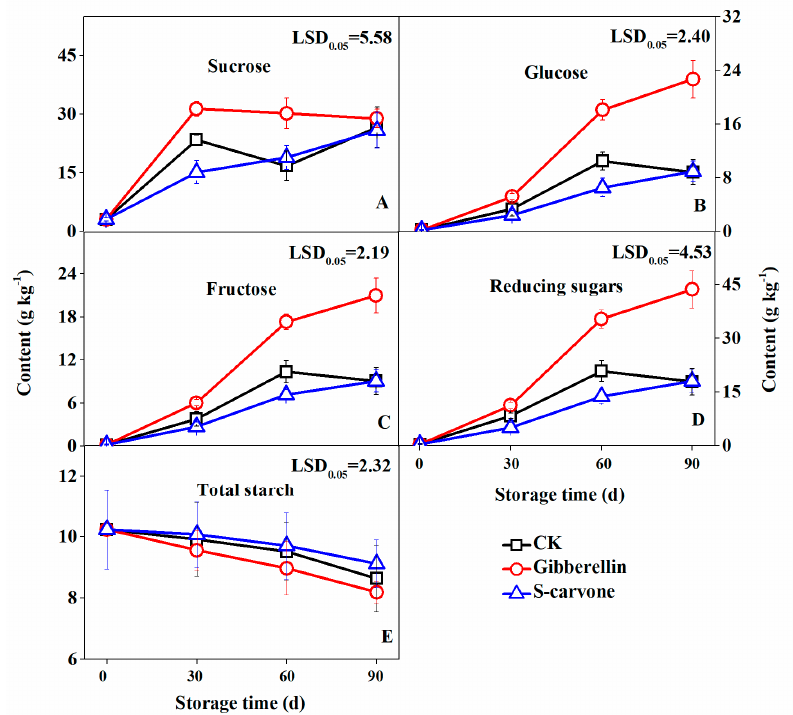
Figure 4. Effects of gibberellin and ( S )-carvone on sugars contents in potato tubers during 4 °C low temperature storage. ( A ) Gibberellin and ( S )-carvone effect on sucrose content. ( B ) Gibberellin and ( S )-carvone effect on glucose content. ( C ) Gibberellin and ( S )-carvone effect on fructose content. ( D ) Gibberellin and ( S )-carvone effect on reducing sugars content. ( E ) Gibberellin and ( S )-carvone effect on total starch content. The error bars represent the standard errors. LSDs represent least significant differences at the 0.05